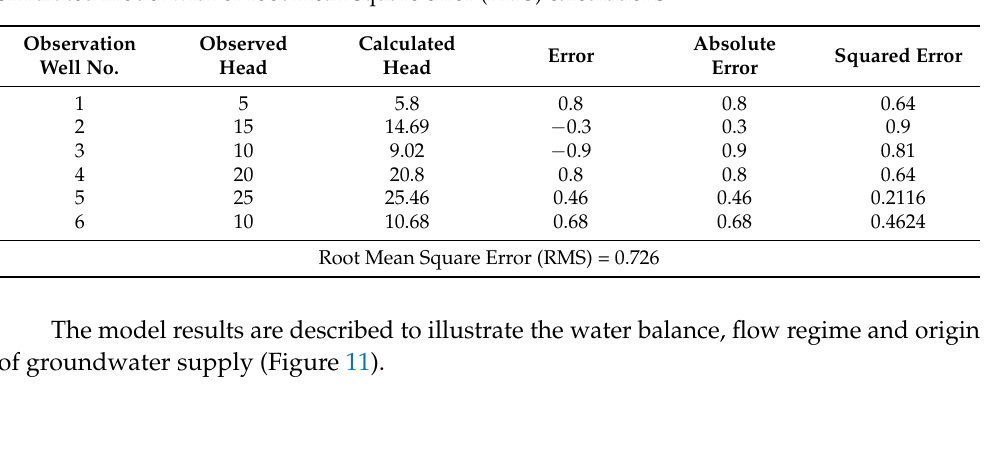
Figure 10. ( a ) Aquifer simulated piezometric heads; ( b ) directions of groundwater flow; ( c ) piezometric heads of observed wells and those of the piezometric heads calculated in their locations for the simulated model with RMS calculations. Table 6. The observed well piezometric heads and the computed heads at their locations for the simulated model with of root mean square error (RMS) calculations.